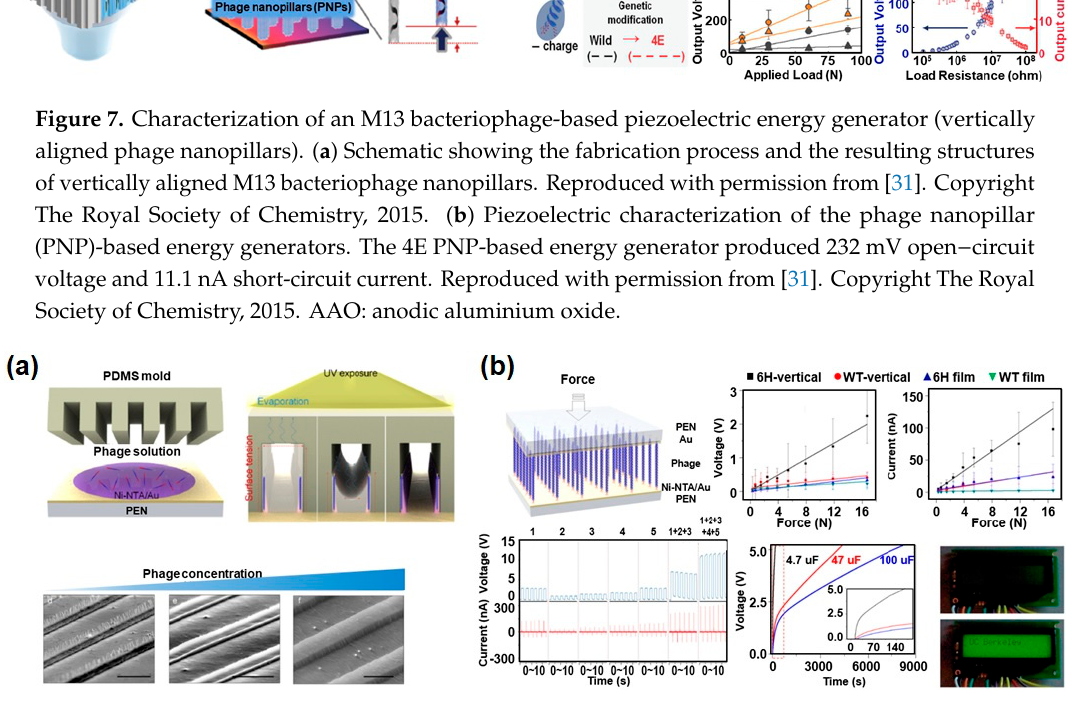
Figure 8. Characterization of an M13 bacteriophage-based piezoelectric energy generator (vertically aligned and unipolarized phage structures). ( a ) Schematic diagram of the fabrication process and scanning electron microscope (SEM) images of vertically aligned phages. Reproduced with permission from [29]. Copyright American Chemical Society, 2019. ( b ) Characterization of vertically aligned phage-based piezoelectric energy harvesters. This device exhibited a peak voltage of 2.8 V and